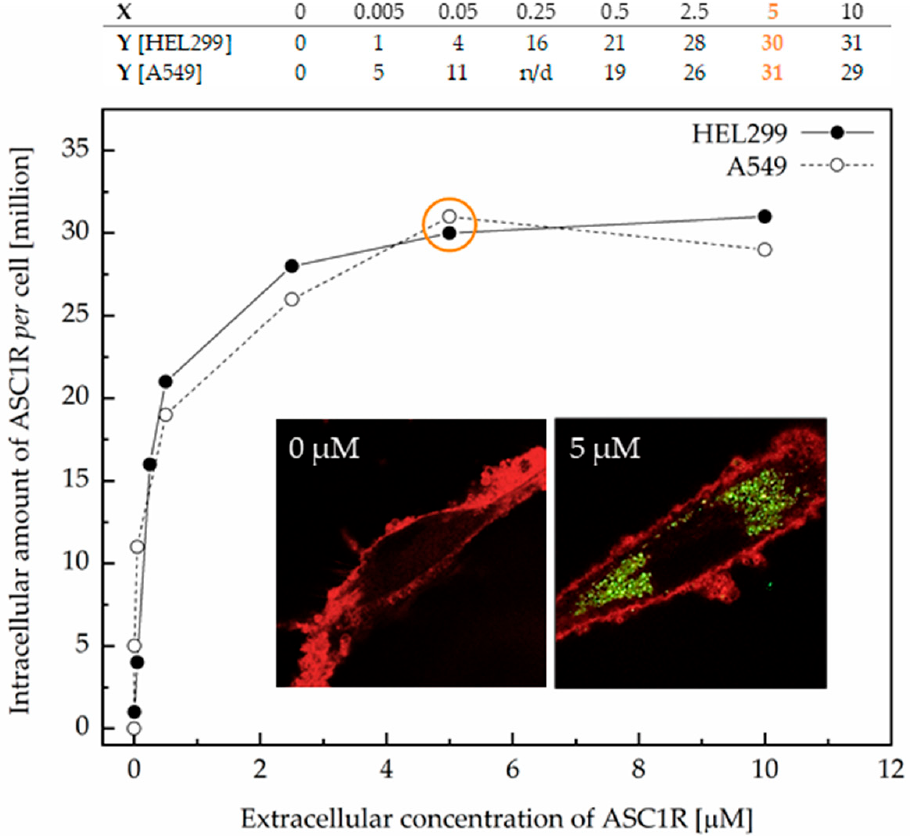
Figure 3. Internalization profile of ASC1R in transfected HEL299 and A549 cells. The insets show representative confocal microscopy images of HEL299 cells with the cell membrane colored red and ASC1R colored green.